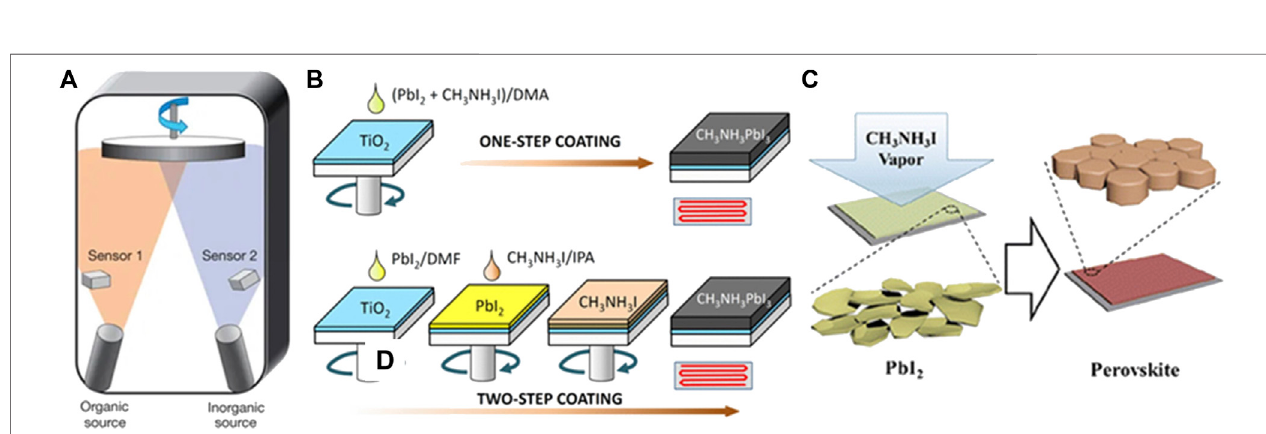
FIGURE3|(A) Dual-sourcethermalevaporation.AdaptedfromLiuetal.(2013)withpermissionfromNaturespringer. (B) One-stepandtwo-stepsolutionprocess for perovskite fi lm growth. Adapted from Im et al. (2014) with permission from Nature springer. (C) Perovskite fi lm formation through vapor-assisted deposition. Reproduced from Chen et al. (2014) with permission from American Chemical